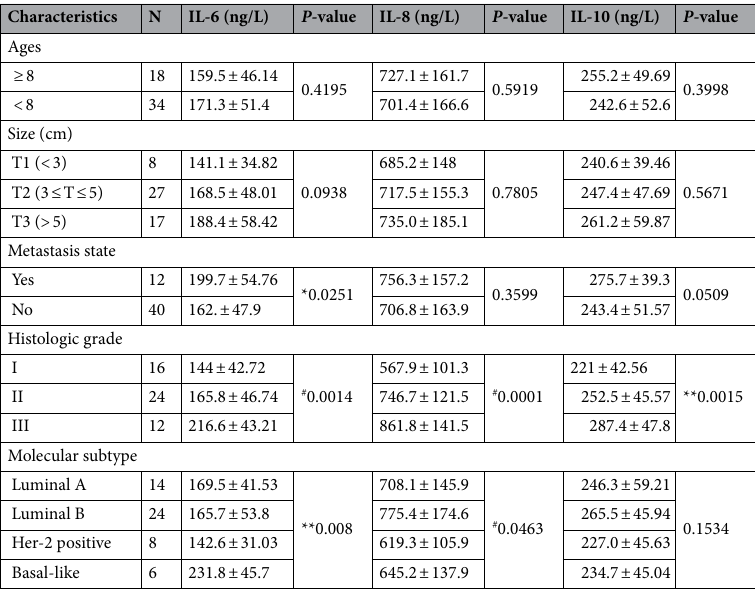
Table 2. Relationship between serum IL-6, IL-8, and IL-10 levels and clinicopathological characteristics in female dogs with malignant CMGTs. *Denotes unpaired t test; **denotes One-way ANOVA test; # denotes Kruskal–Wallis; P < 0.05 was considered to be statistically